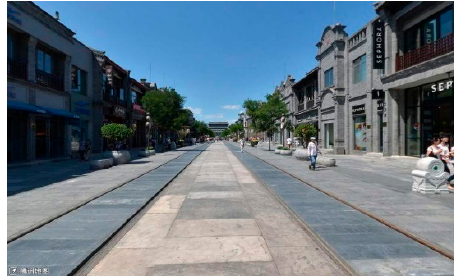
Figure 2. Tencent Street View static image application program interface.